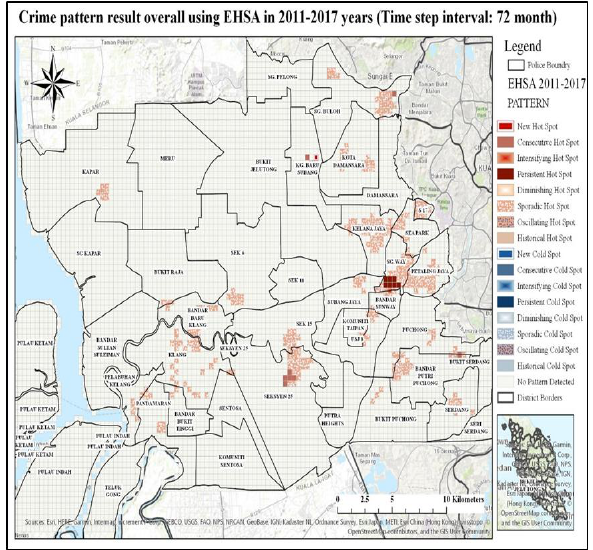
Figure 8: Crime pattern result using EHSA in 2011-2017 years The results generated by the tool space time cube show; trend